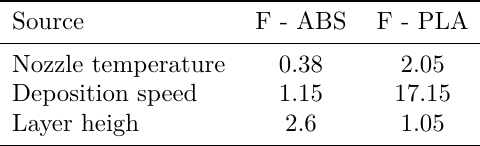
Table 5. Morphology F factors